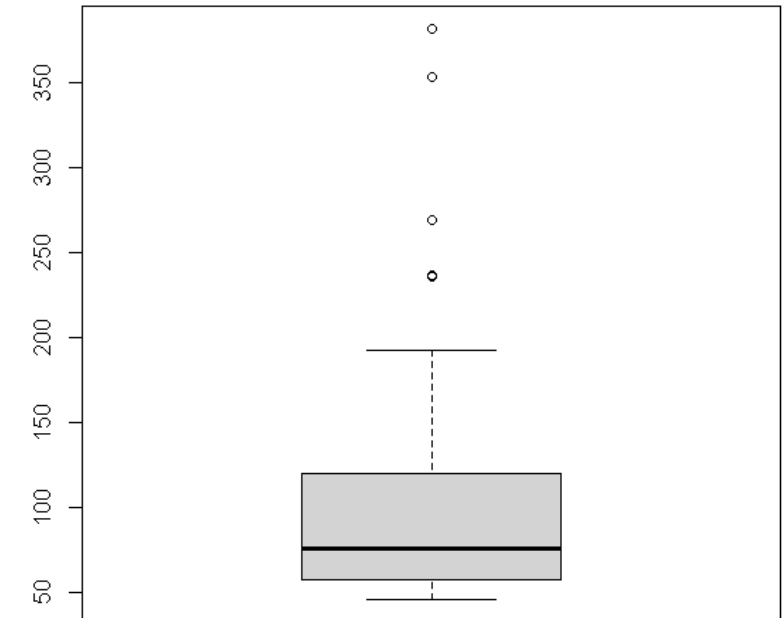
Figure 1. Box plot of the top 50 data of GDP of China in 2019.